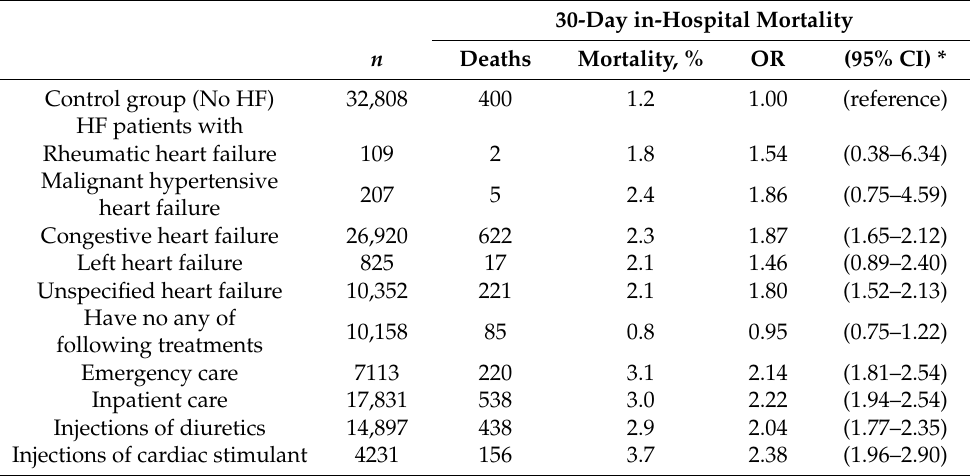
Table 4. The mortality after noncardiac surgery in patients with characteristics of heart